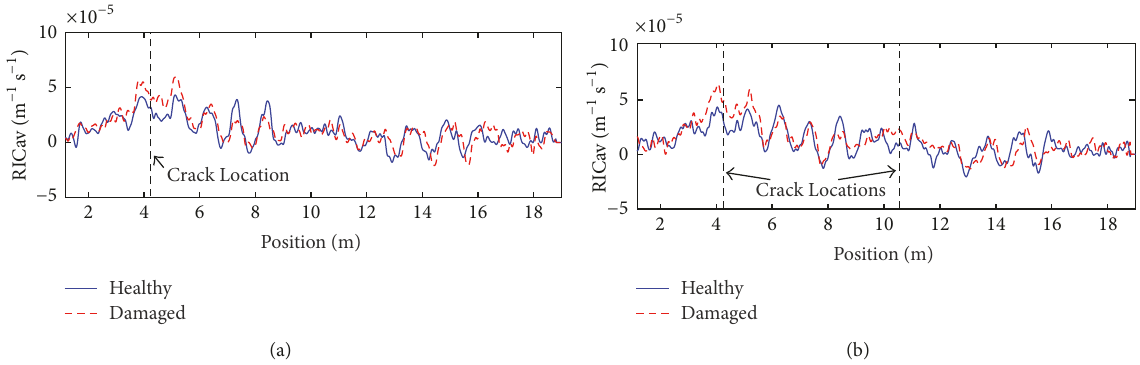
Figure 13: Comparison of RIC av for healthy and damaged cases with noisy measurements: (a) the first damage case and (b) the second damage case.